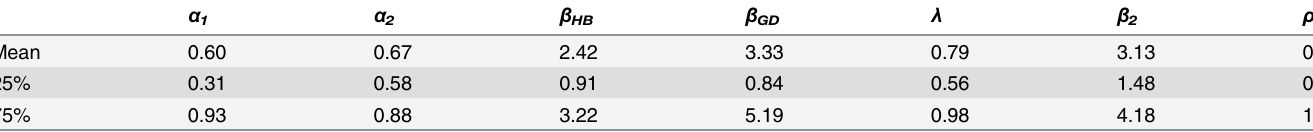
Table 2. Computational model parameters: maximum a posteriori (MAP) estimates (bounded model-scale).